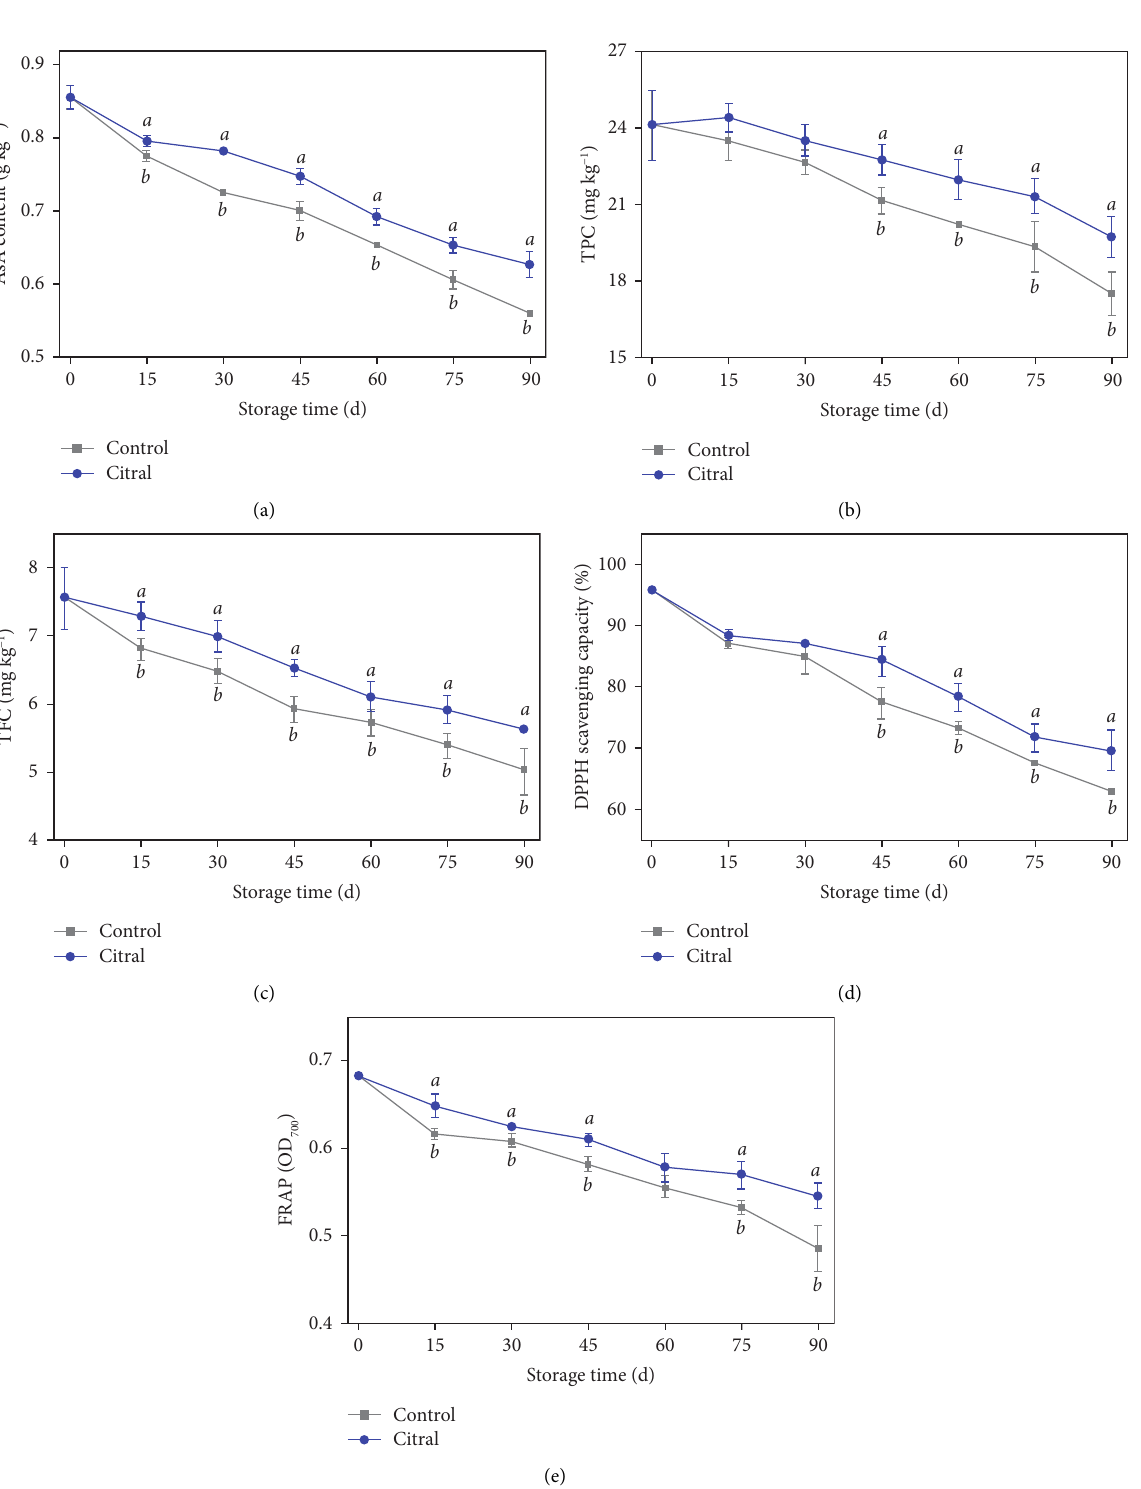
Figure 4: Effect of citral treatment on AsA content, (a) total phenolics content (TPC), (b) total flavonoids content (TFC), (c) 2,2-diphenyl-1- picrylhydrazyl (DPPH) scavenging capacity, (d) and ferric reducing antioxidant power (FRAP) (e) of harvested kiwifruit stored at 0-1 ° C for 90d. Vertical bars represent the mean ± standard error (S.E., n � 3). Letters indicate the statistical differences according to the independent samples t -test ( p < 0 . 05) on each storage